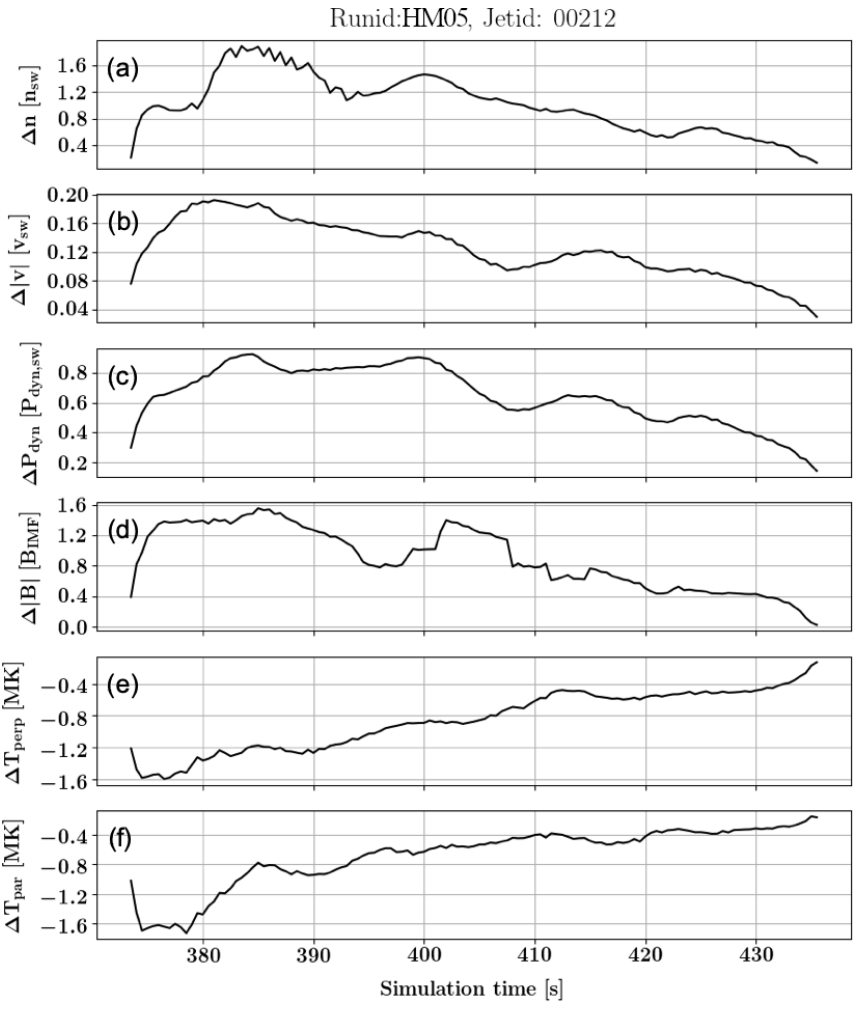
Figure 10. The difference between the jet and magnetosheath (a) density, (b) velocity, (c) dynamic pressure, (d) magnetic field intensity, (e) perpendicular temperature, and (f) parallel temperature as a function of jet lifetime in the simulation for a chosen particularly strong jet in run HM05 (purple curves in Figs. 7–9). All other parameters are normalised to the solar wind, while the temperature data are given in